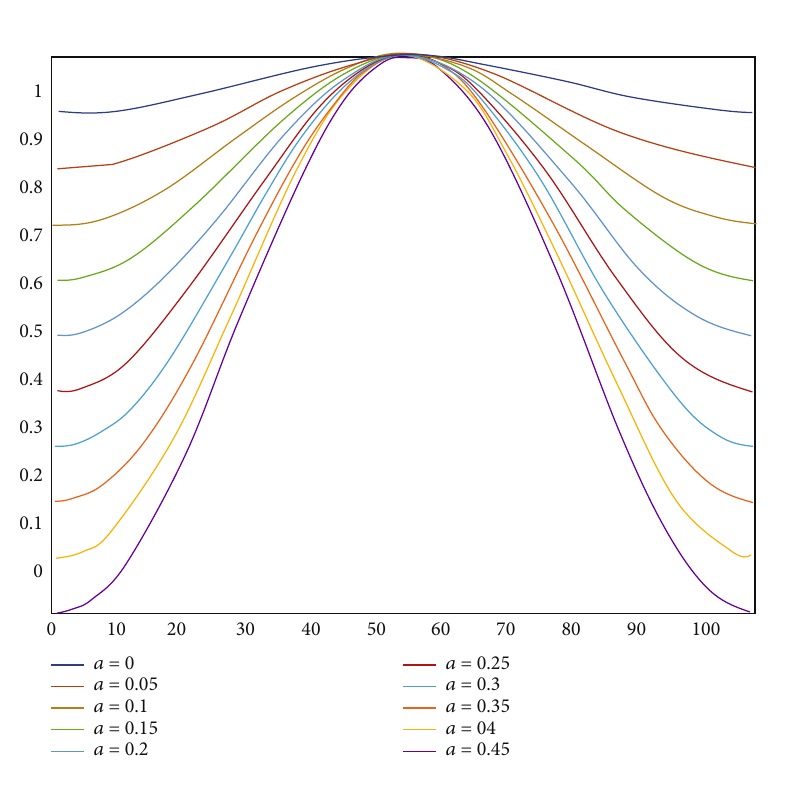
Figure 6: Comparison of classi fi cation results based on three